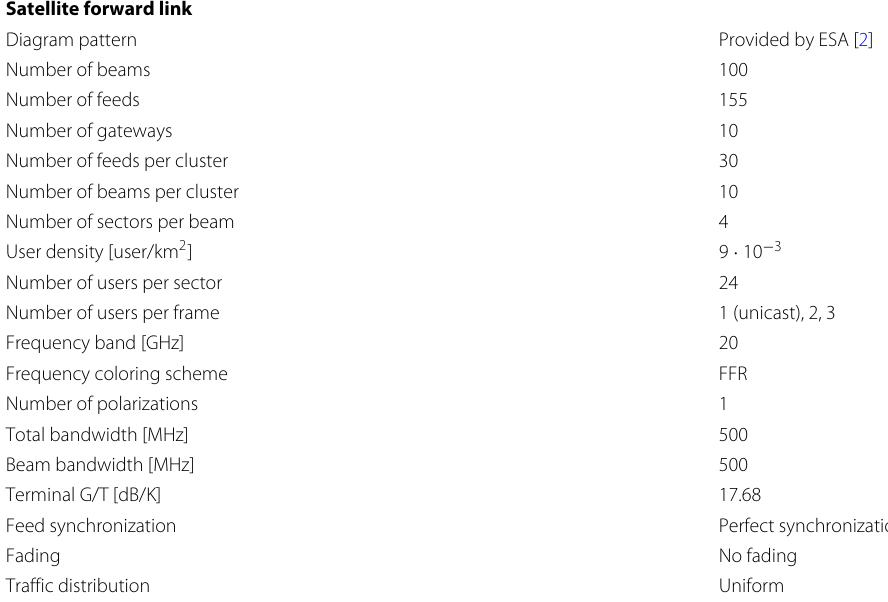
Table 2 Satellite system